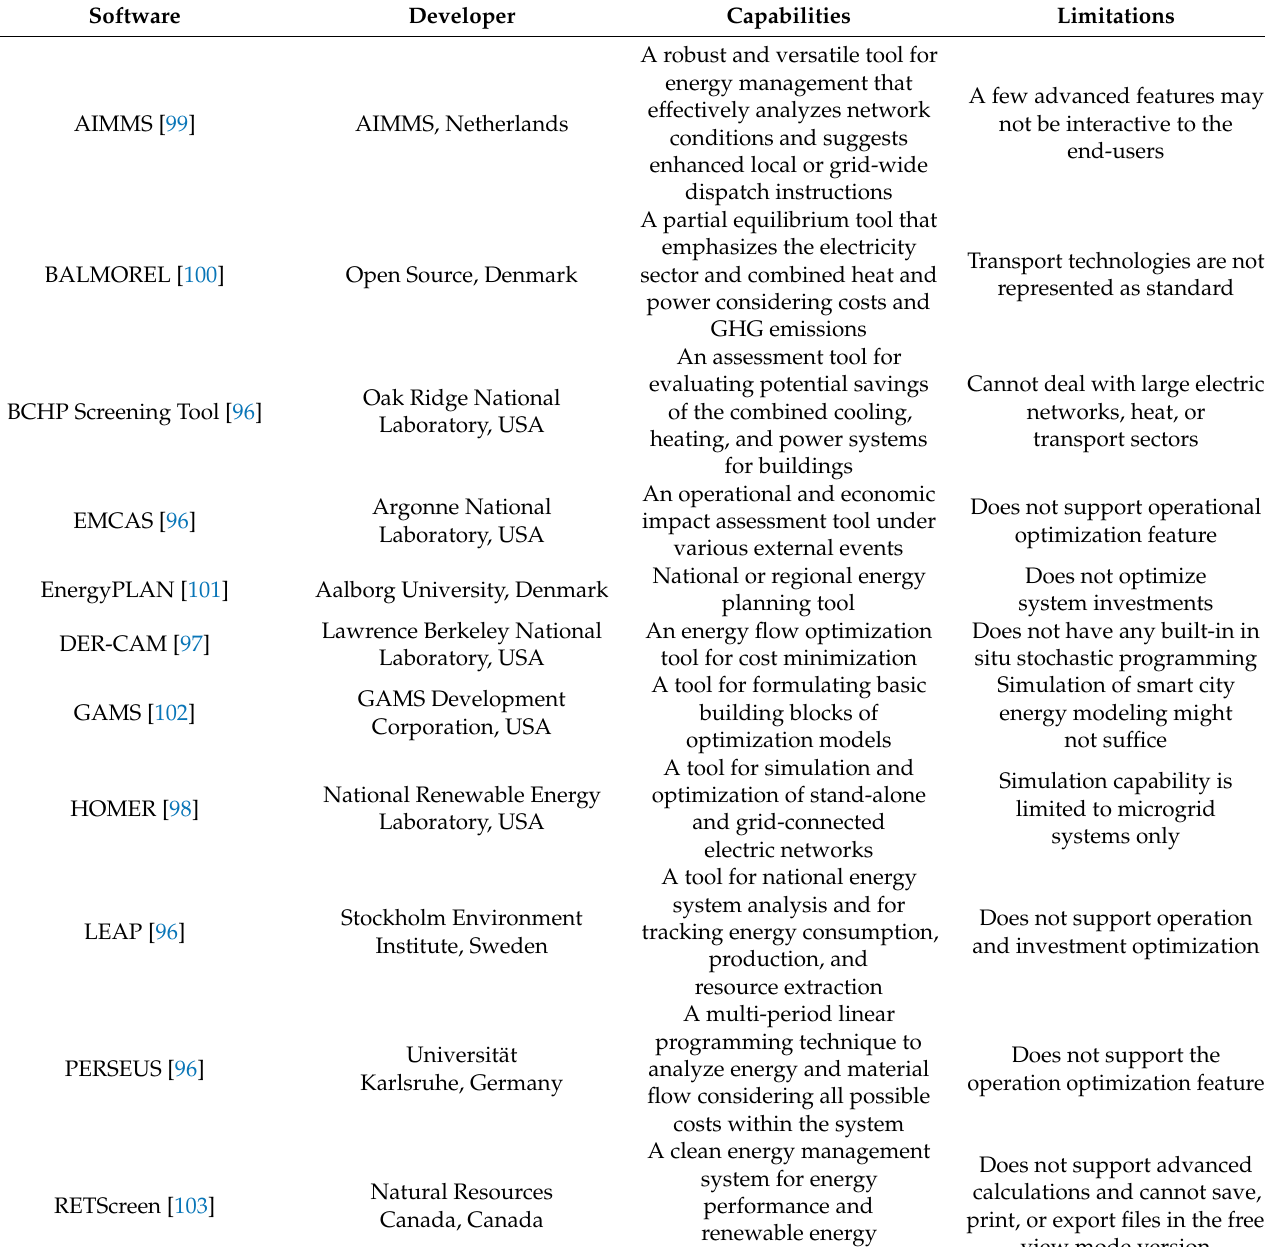
Table 3. Relevant energy modeling